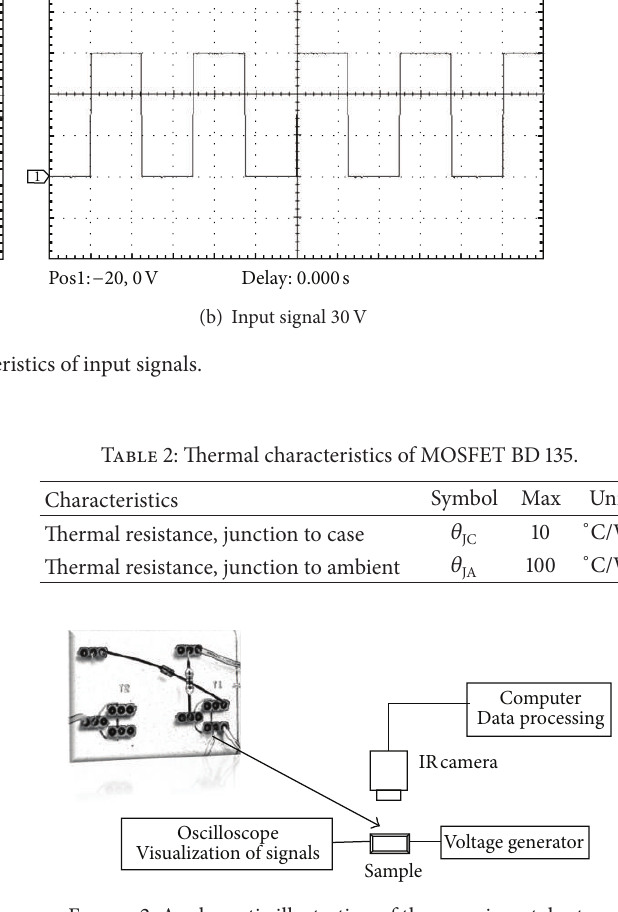
Figure 2: A schematic illustration of the experimental